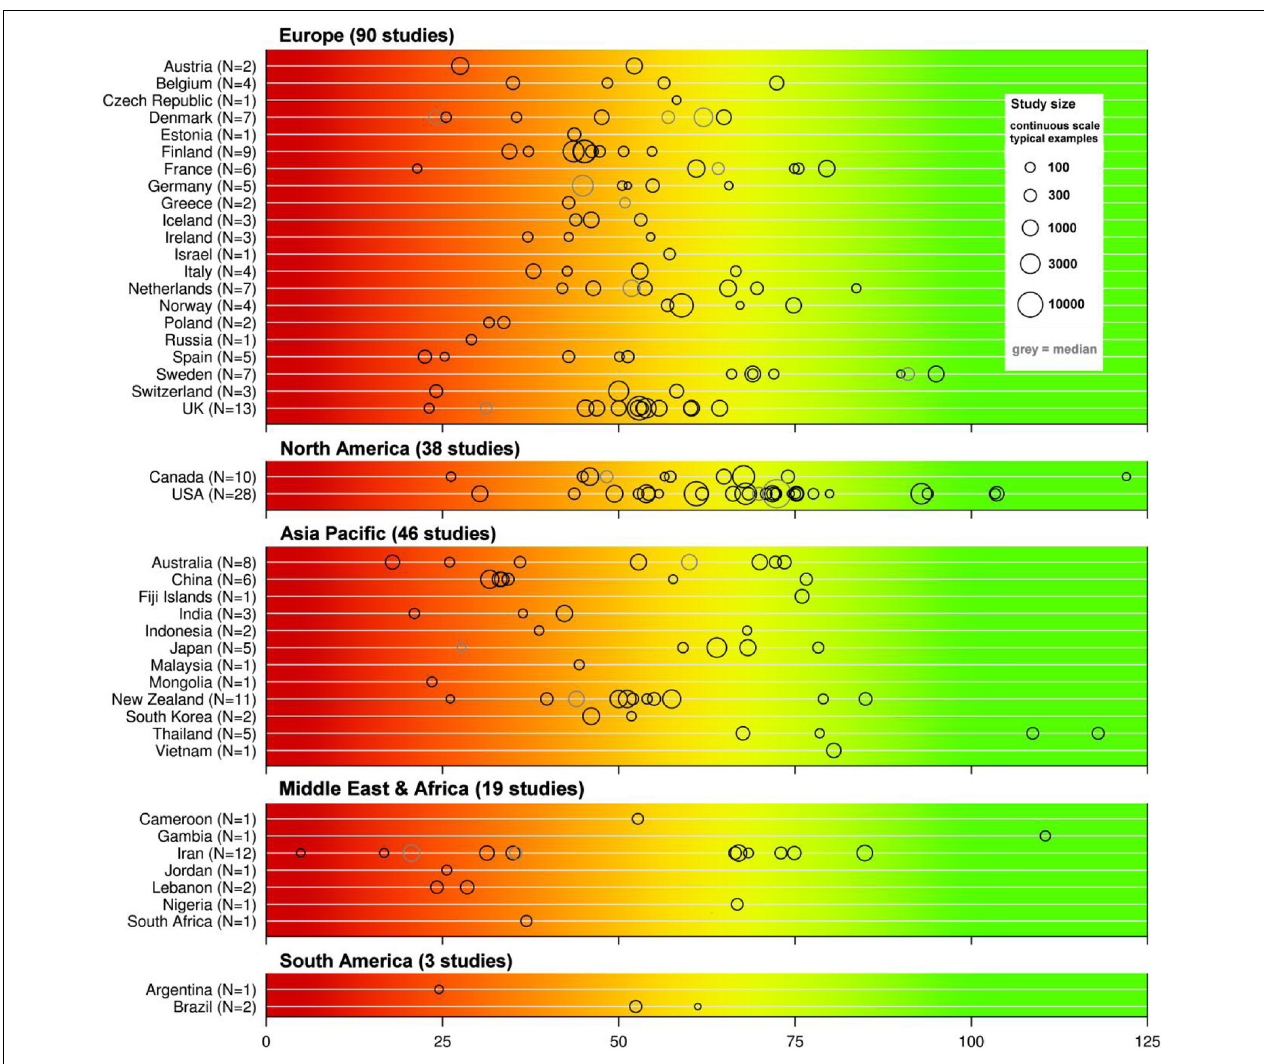
FIGURE 1 | Overview of published 25-hydroxyvitamin D mean/median values by countries (modified from Hilger et al., 2014). The color trend from red, yellow to green shown above the graphical diagram represents the current uncertainty around the definition of 25-hydroxyvitamin D 3 serum thresholds starting from severe deficiency